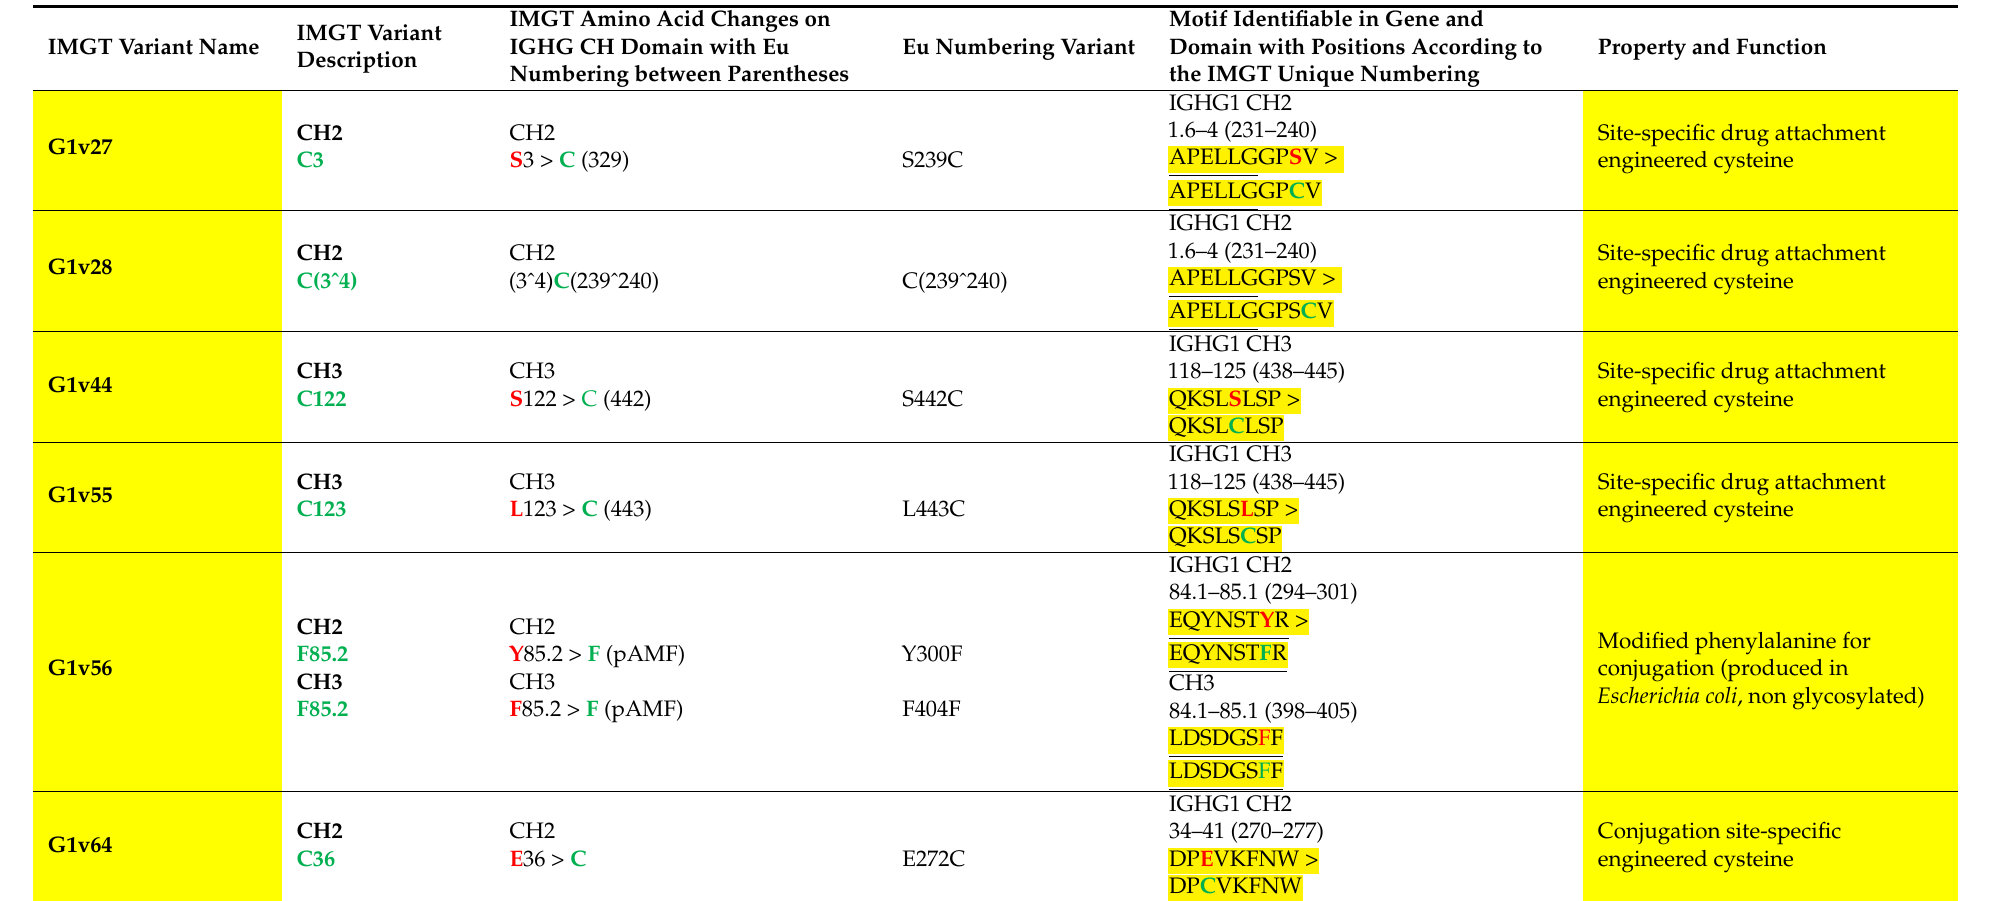
Table 20. IMGT nomenclature, Eu positions and IMGT motif of engineered Fc variants involved in site-specific drug attachment (Structure